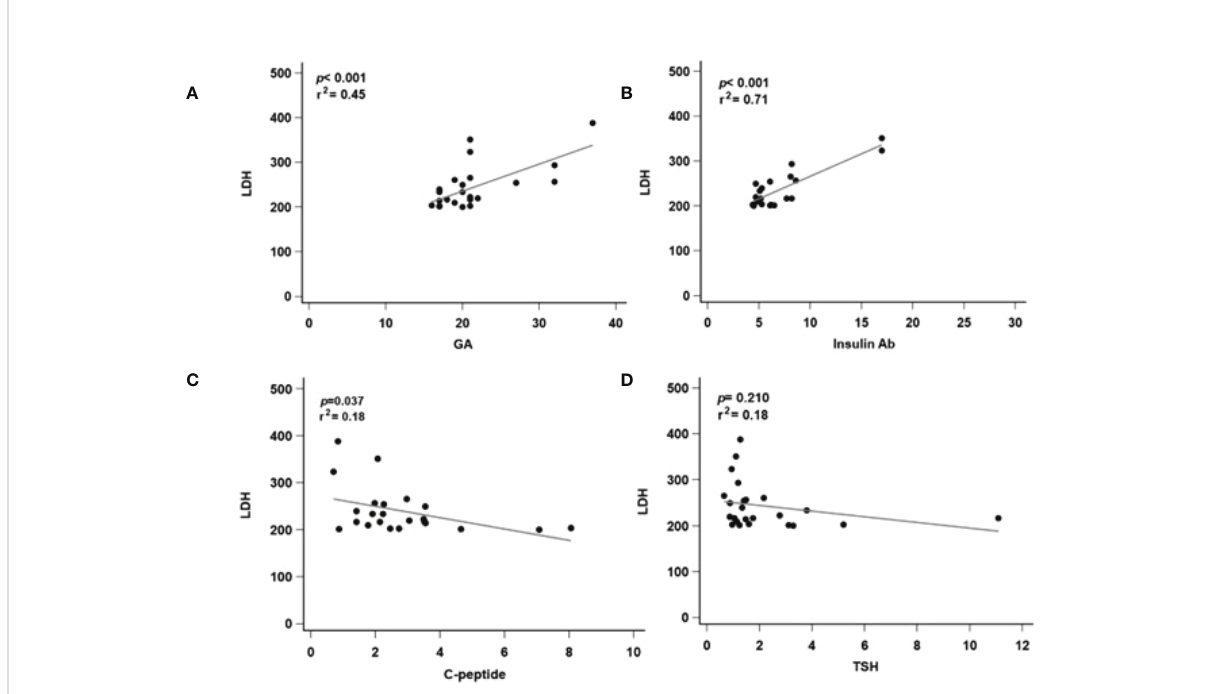
FIGURE 3 Regression analysis of related markers in high serum level of LDH groups. LDH, lactate dehydrogenase; GA, glycated albumin; C-peptide, connecting peptide; insulin Ab, insulin antibodies; TSH, thyroid-stimulating hormone. (A) The correlated with serum LDH and GA level. (B) The correlated with serum LDH and insulin Ab level. (C) The correlated with serum LDH and C-peptide level. (D) The correlated with serum LDH and TSH level. p , p-value; r 2 : r-squared.